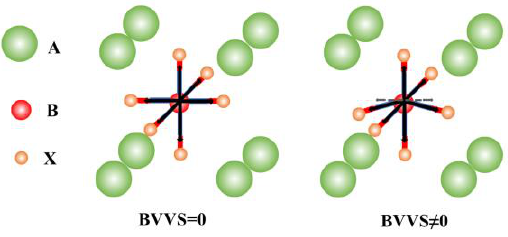
Figure 1. Schematic diagram of the bond-valence vector sum. Table 1. Perovskite original feature descriptor set and its physical